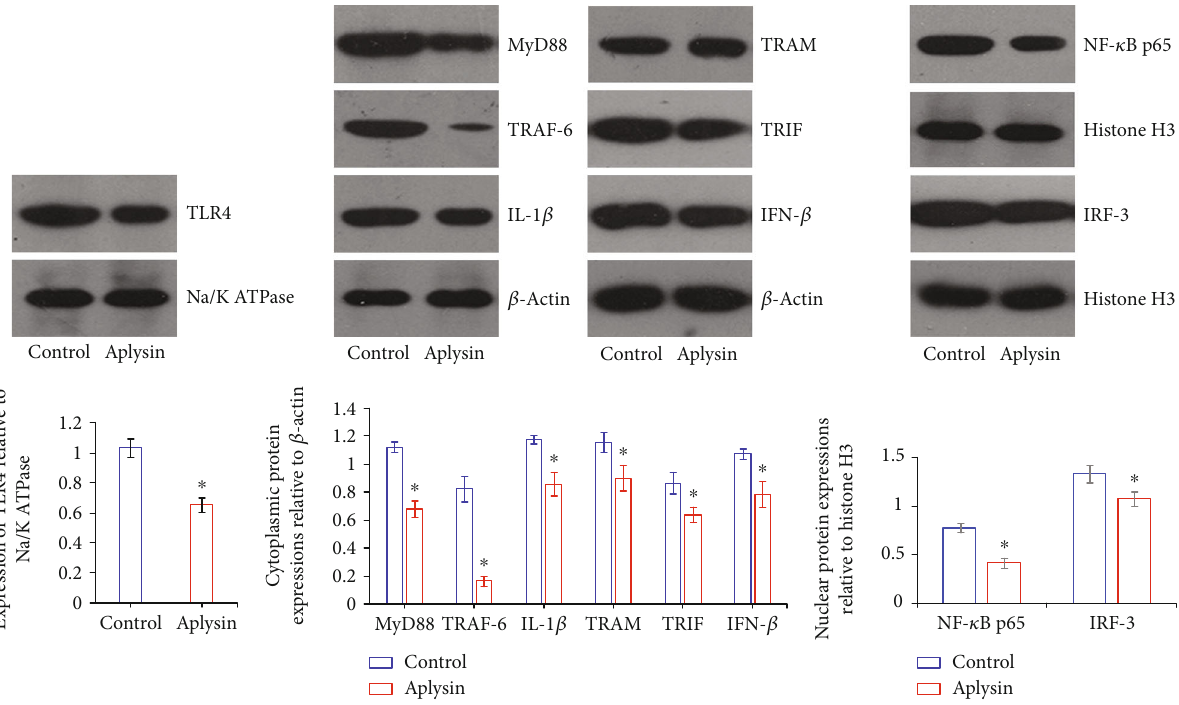
Figure 4: Expressions of TLR4 and its downstream e ff ectors in pancreatic tissues. Representative blots for TLR4, MyD88, TRAF-6, IL-1 β , TRAM, TRIF, IFN- β , NF- κ B p65, and IRF-3 in the pancreas of aplysin-treated or untreated mice were analyzed by Western blotting. Na/K ATPase, β -actin, and histone H3 were used as internal controls for membrane proteins, cytoplasmic proteins, and nucleoproteins, respectively. ∗ p < 0 : 05 vs. the control